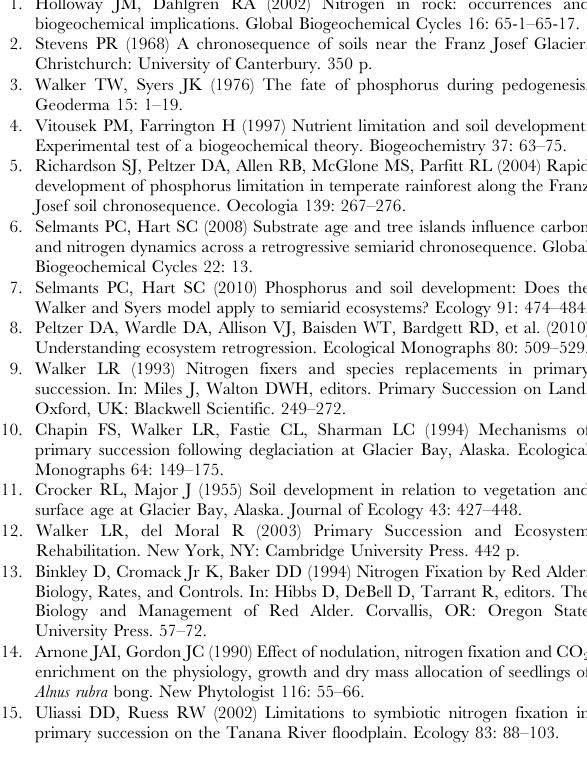
Figure S2 Simulation to evaluate effects of forced rapid fluctuations. Pools and fluxes of plant-available